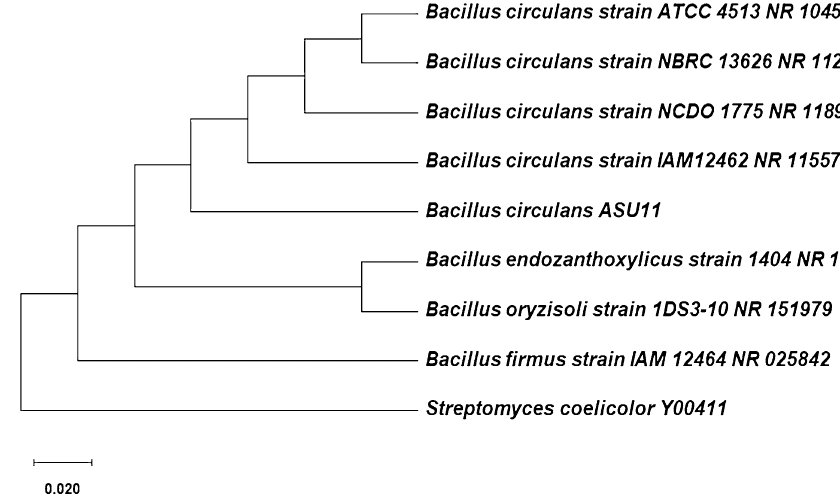
Figure 5. Phylogenetic tree of lipase producing strain Bacillus circulans ASU11 (MT919306).